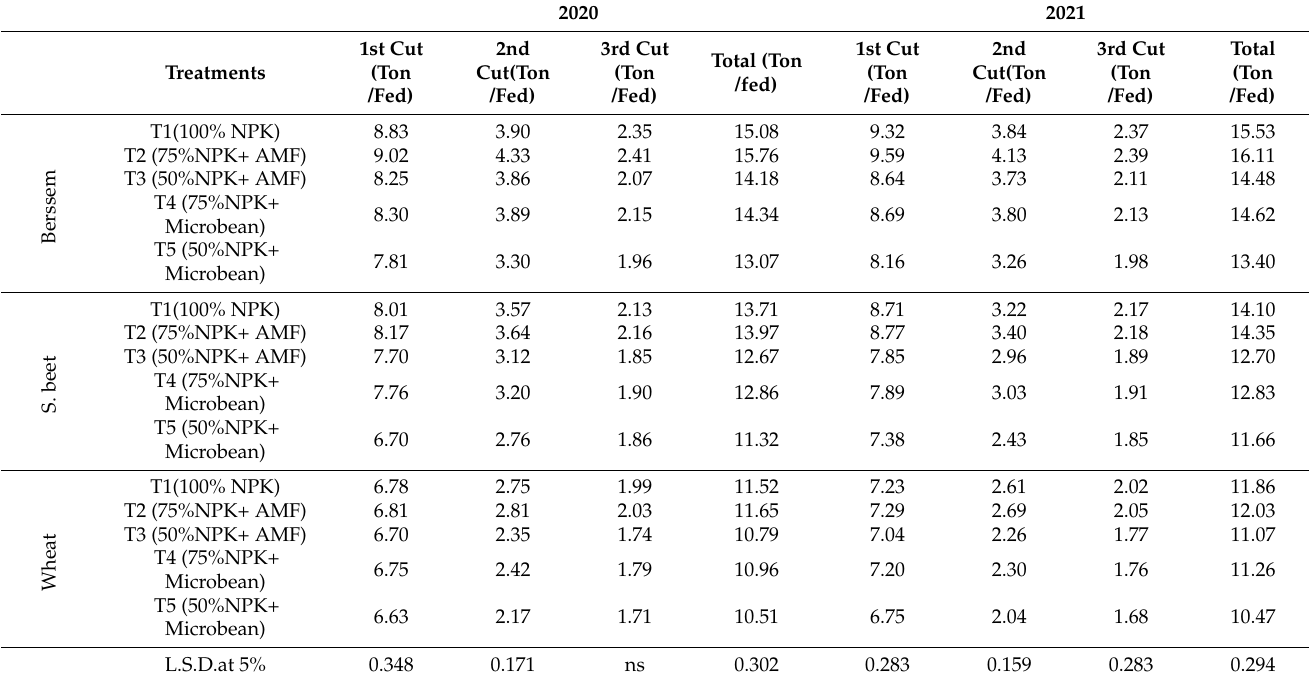
Table 8. The effect of interaction on cowpea forage yield cuts (ton/fed) under intercropping system during 2020 and 2021